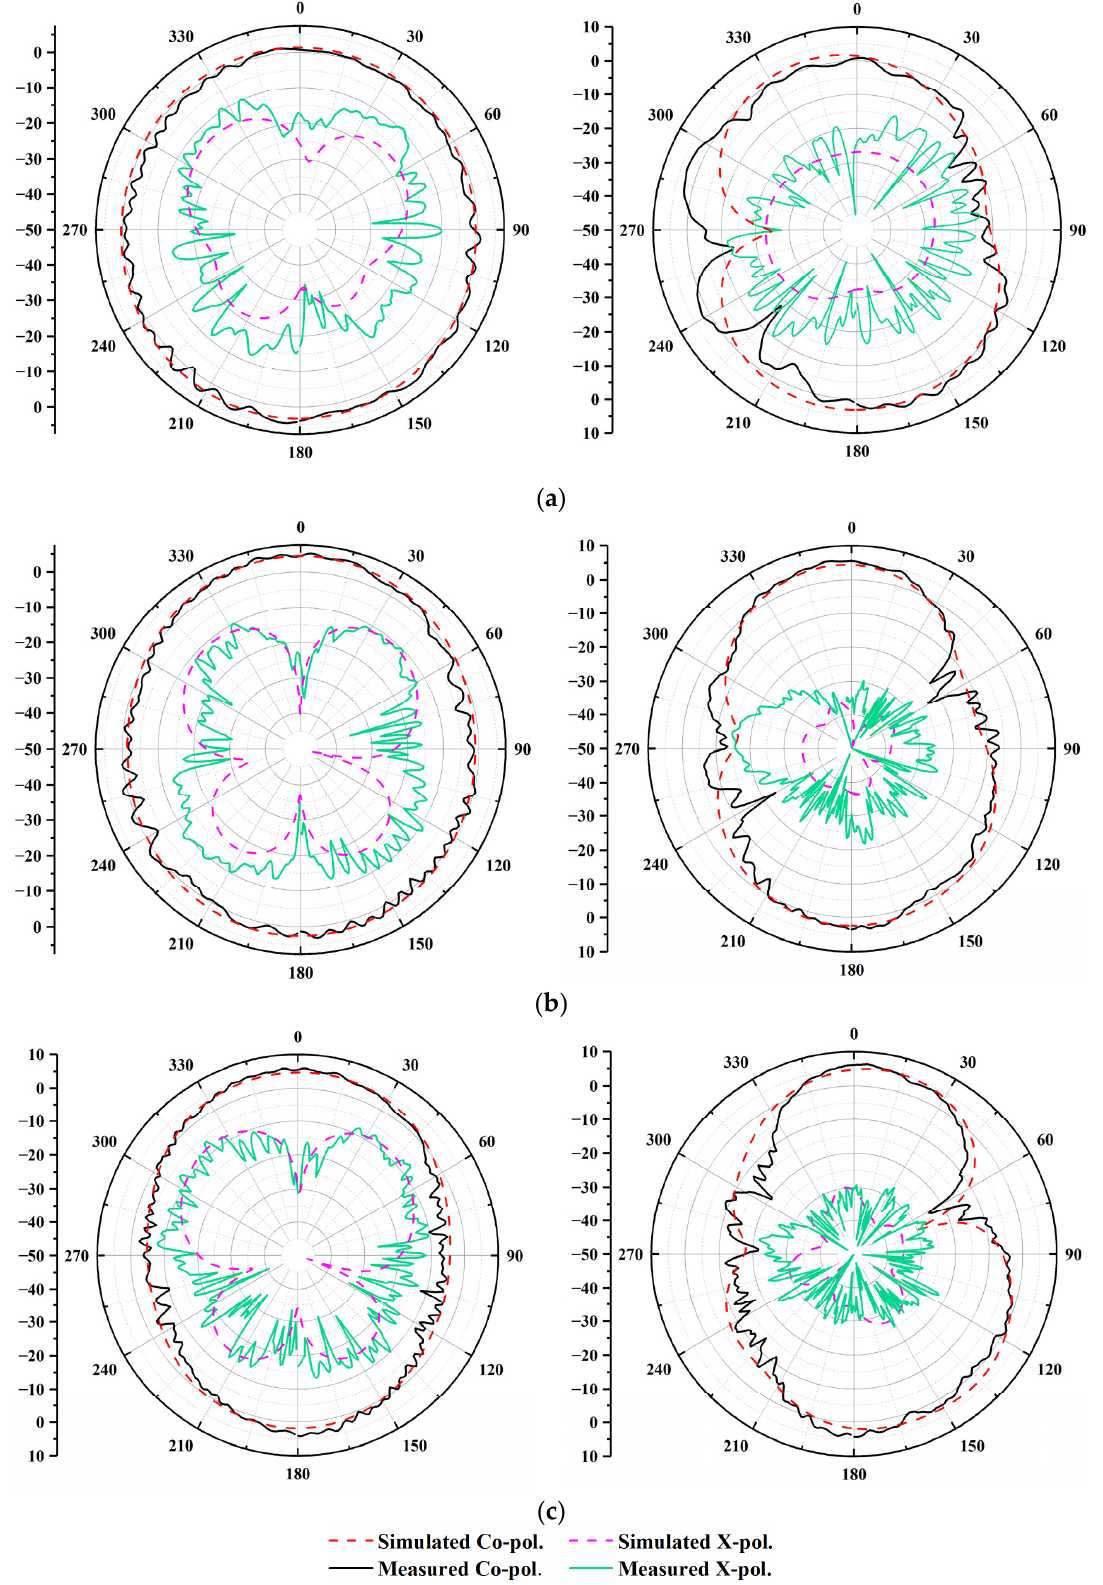
Figure 15. Simulated and measured radiation patterns. X-Z Plane ( left ) and Y-Z Plane ( right ). ( a ) 6 GHz, ( b ) 8 GHz, and ( c ) 10 GHz.